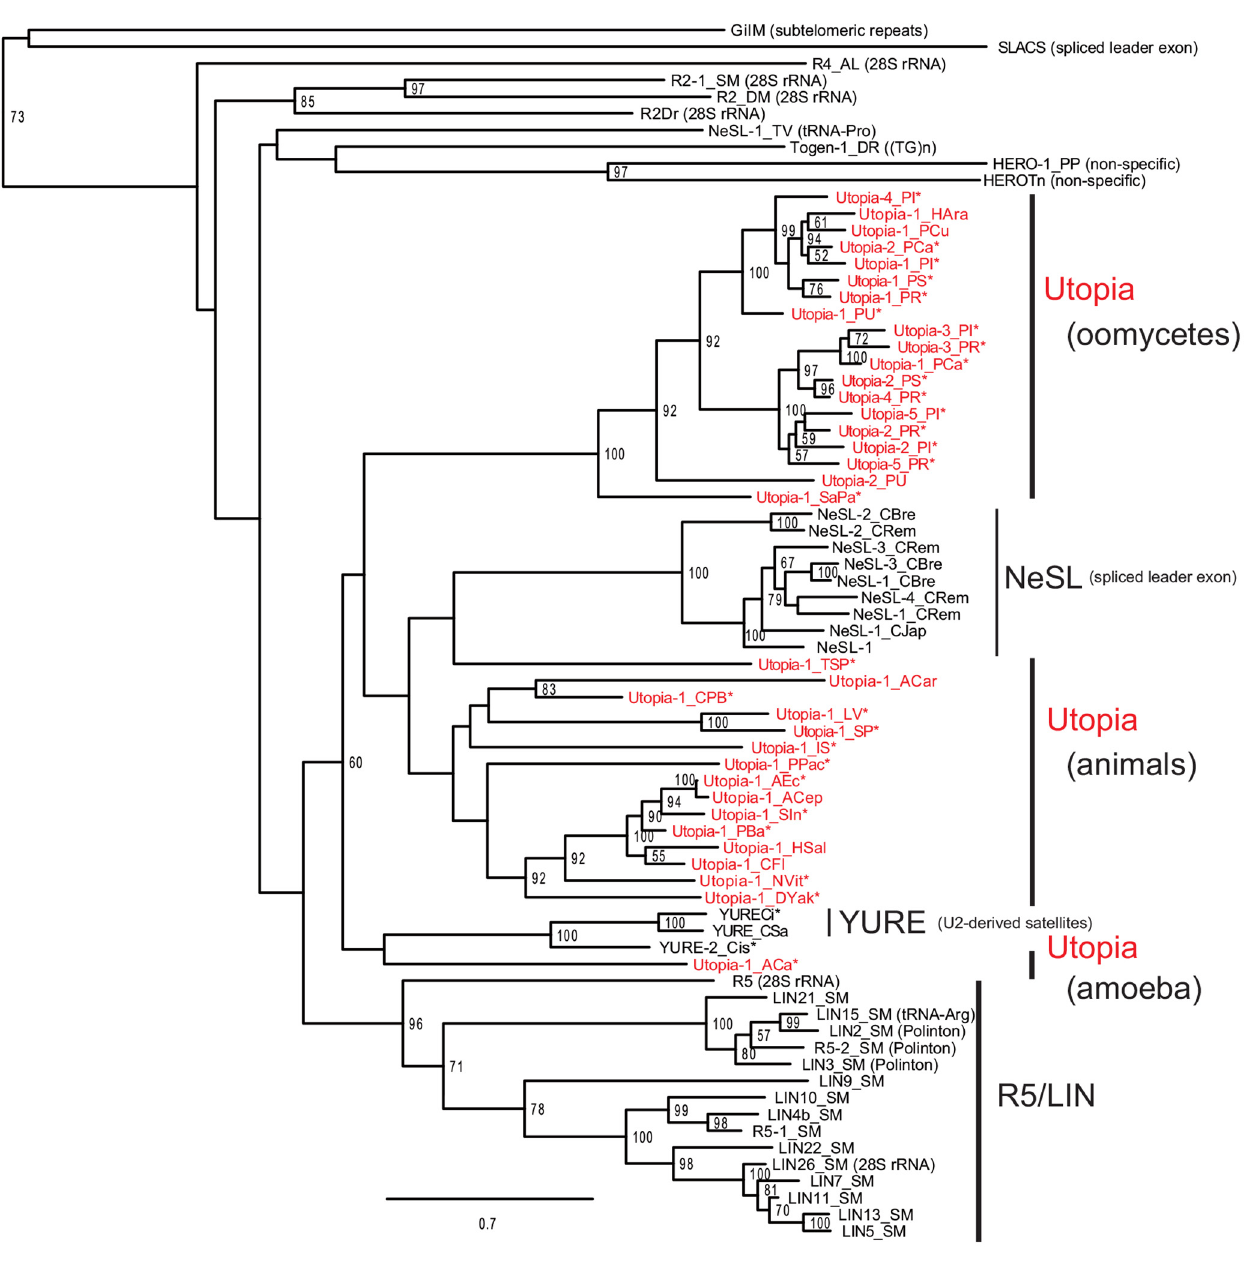
Fig 5. The phylogeny of Utopia and other non-LTR retrotransposons related to the NeSL clade. SLACS and GilM were used as outgroups [4],[46]. Numbers at nodes indicate bootstrap values of 100 replicates; only values over 50 are shown. Asterisks indicate Utopia families of which at least one copy is flanked by U2 gene sequences. Target repeats are shown in parentheses after family names other than Utopia